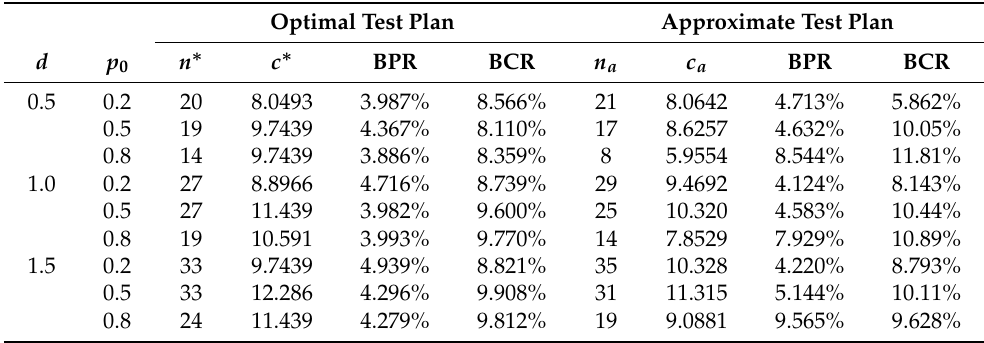
Table 2. Optimal and approximate plans, ( n ∗ , c ∗ ) and ( n a , c a ) , and the corresponding Bayesian risks, BPR and BCR, when λ 0 = 0.3, λ 1 = 0.7, α = 0.05, β = 0.10 and d 0 = d 1 = d